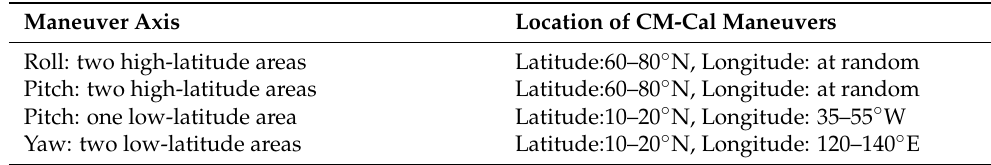
Table 3. GRACE-type satellite CM-Cal maneuver